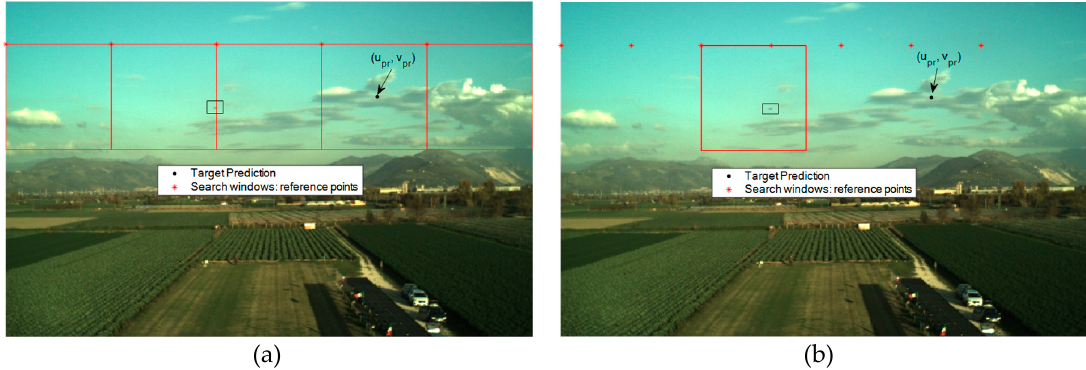
Figure 4. DL-based detector: example of search windows definition for a 752 × 480-pixels RGB image. The target UAV position is highlighted by a black box. ( a ) d u is set to 150 pixels ( N w = 5). The target UAV projection on the image plane is cut by the border between the second and third search window. ( b ) d u is set to 100 pixels ( N w = 7). Only the third search window, which fully contains the target UAV, is highlighted for the sake of clarity.